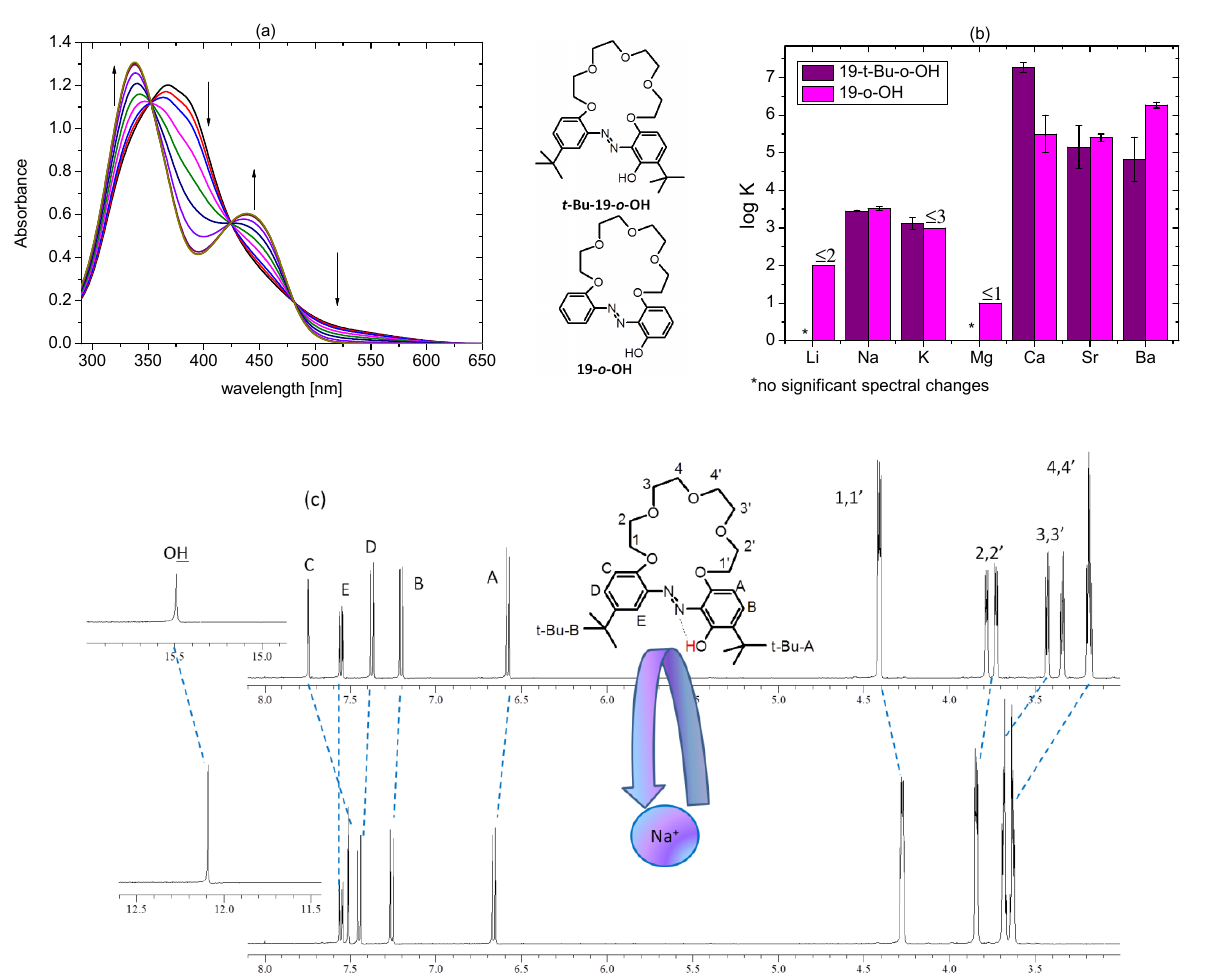
Figure 17. ( a ) Changes in UV-Vis spectra upon titration of 19- t -Bu- o -OH (7.33 × 10 − 5 M) with calcium perchlorate (0–1.19 × 10 − 4 M) in acetonitrile; ( b ) comparison of the stability constants values (log K) of 1:1 complexes of 19-membered o -hydroxyazobenzocrowns— t -Bu-19- o -OH and 19- o -OH [26] in acetonitrile ( c ) partial (oligoether and aromatic proton signals range) 1 H NMR spectrum of t -Bu-19- o -OH (top; 6.3 × 10 − 3 M) registered in the presence of a 10-fold excess of sodium perchlorate (acetonitrile- d 3